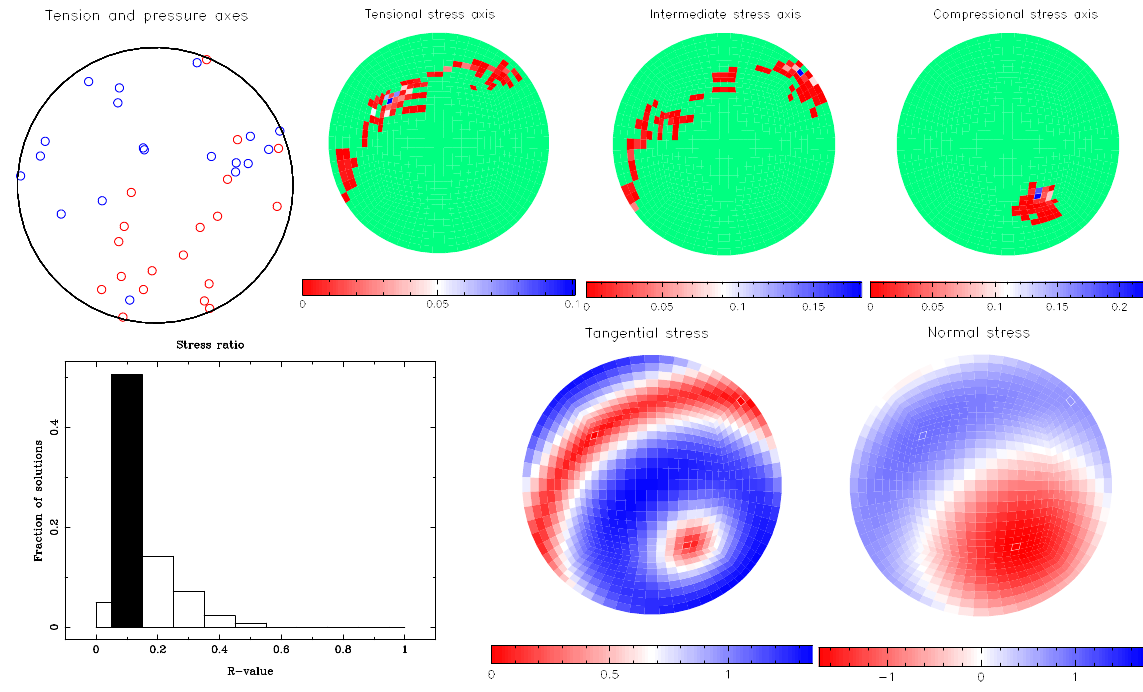
Fig. 7. Results of stress inversion for cluster of shallow earthquakes south of Karpathos. Explanation of subfigures is as in Fig. 5. 16 W. Friederich et al.: Focal mechanisms and stress field in the Southern Aegean